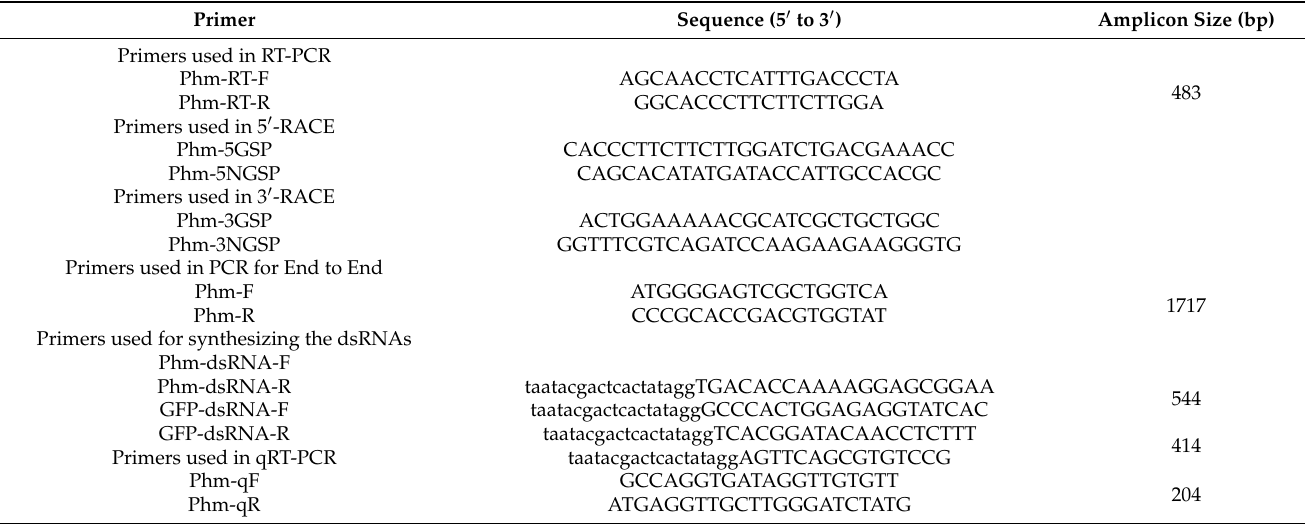
Table 1. Primers used for validation of Cs-Phantom , 5 (cid:48) and 3 (cid:48) RACE, and quantitative real-time